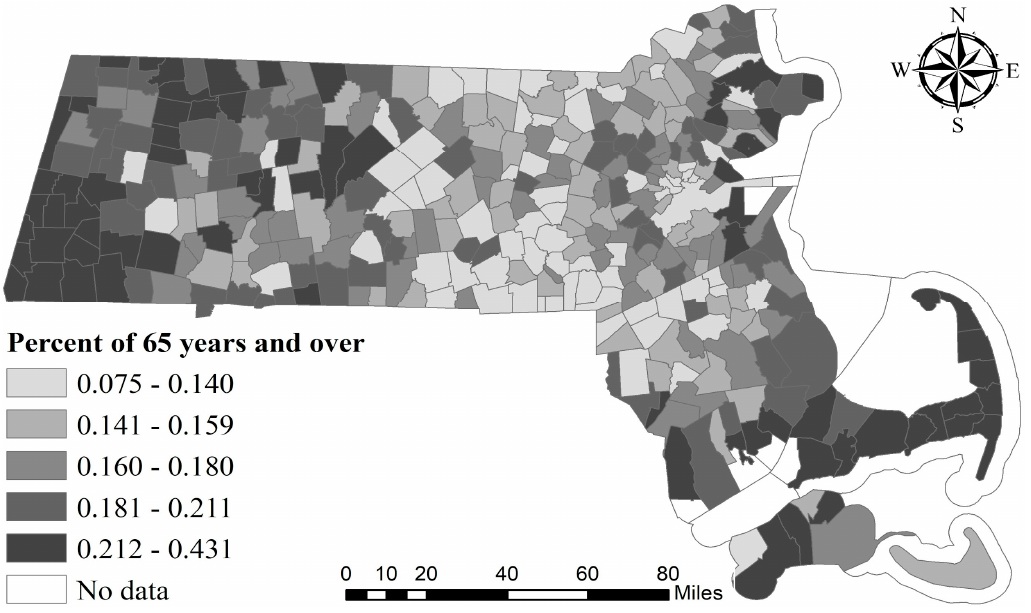
Figure 4. Geographical distribution of percentage of population 65 years and over.